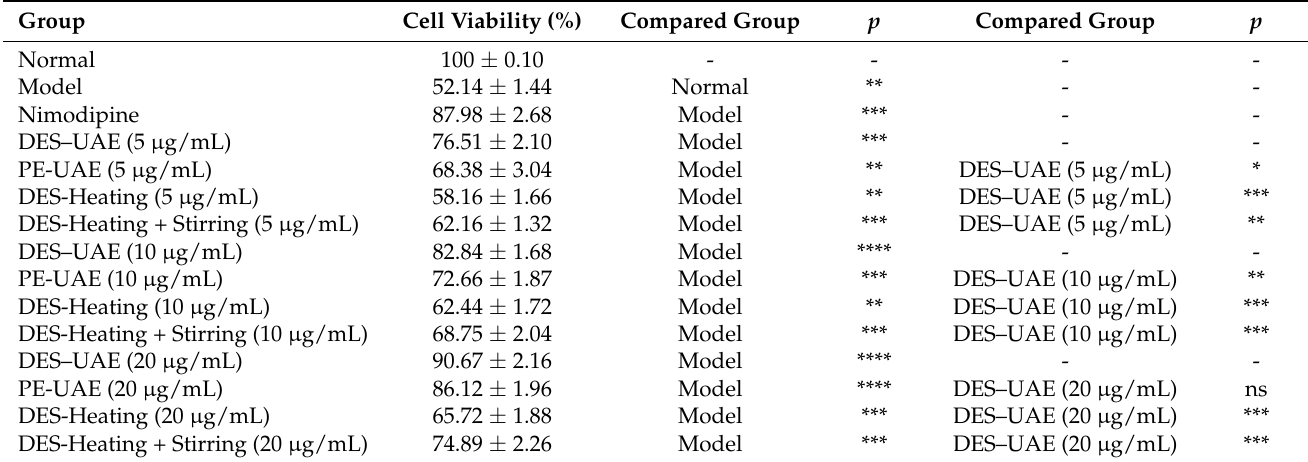
Table 6. The neuroprotective activities of the extracted macamide products on PC12 cells.